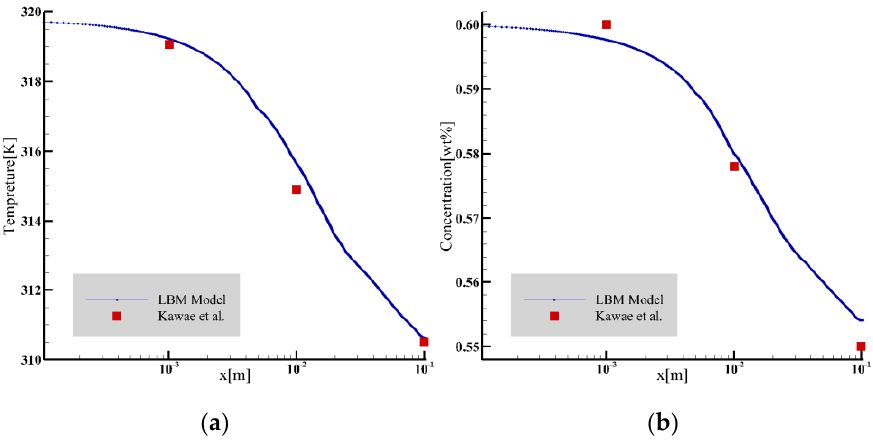
Figure 3. The temperature and concentration profiles were compared with the results of Kawae et al. [24]. ( a ) Temperature comparison; ( b ) concentration comparison. et al. [24]. ( a ) Temperature comparison; ( b ) concentration